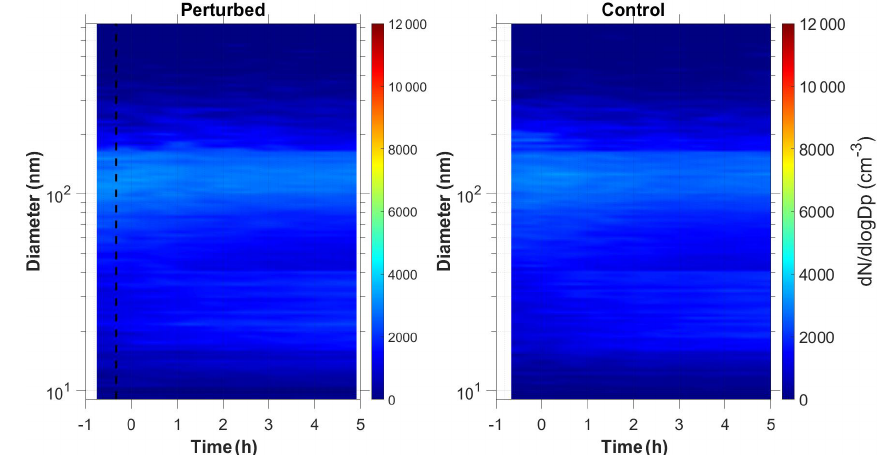
Figure 4. Wall loss corrected measured number distributions in the two chambers for Exp. C1.